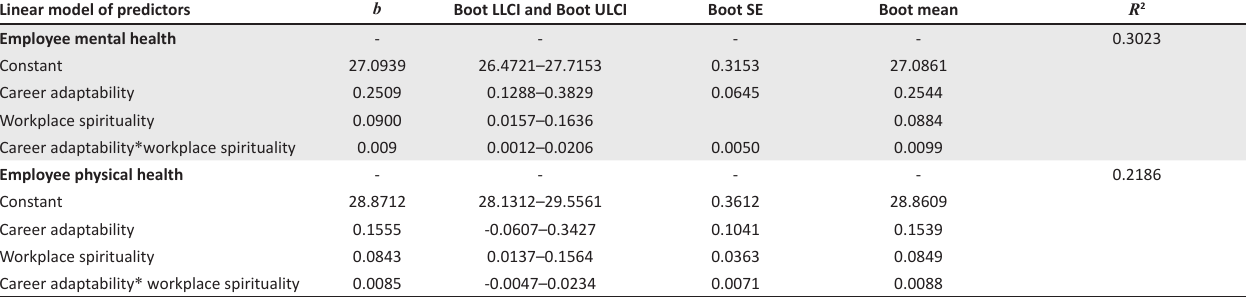
TABLE 7: Bootstrap results for employee mental and physical health. Linear model of predictors